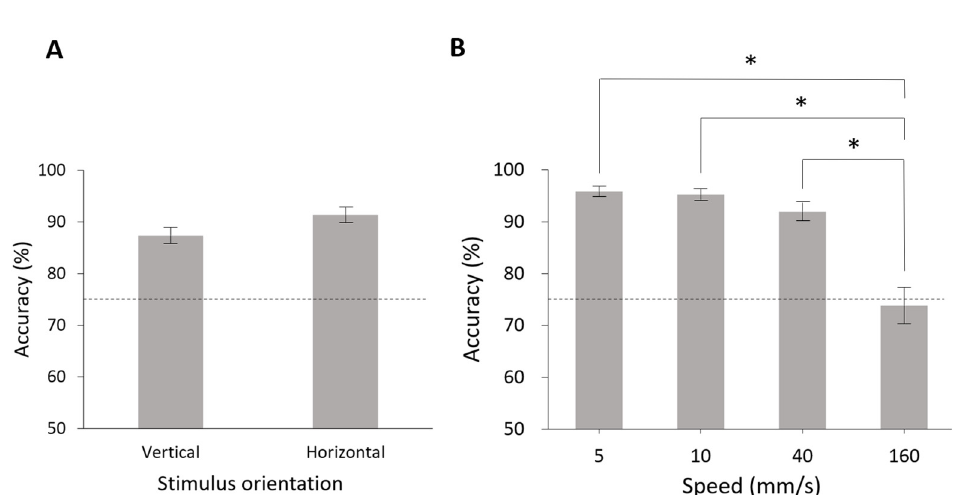
Figure 3. Performance results in terms of accuracy of orientation identification in different stimulus orientations and speeds. ( A ) Comparison of accuracy for the vertical and horizontal orientations revealed no significant difference ( p = 0.08). The accuracy for stimulus orientations of vertical and horizontal were 87.35 ± 1.55% and 91.37 ± 1.49%, respectively. The error bars indicate SEM. ( B ) Comparison of accuracy for speeds of 5, 10, 40, and 160 mm/s revealed that tactile accuracy differed across 160 mm/s and the other speeds ( p < 0.001, Friedman test). The accuracy for speeds of 5, 10, 40, and 160 mm/s were 95.83 ± 0.98%, 95.24 ± 1.06%, 91.96 ± 1.77%, and 73.81 ± 3.48%, respectively, * indicates p < 0.05 in post hoc comparisons.